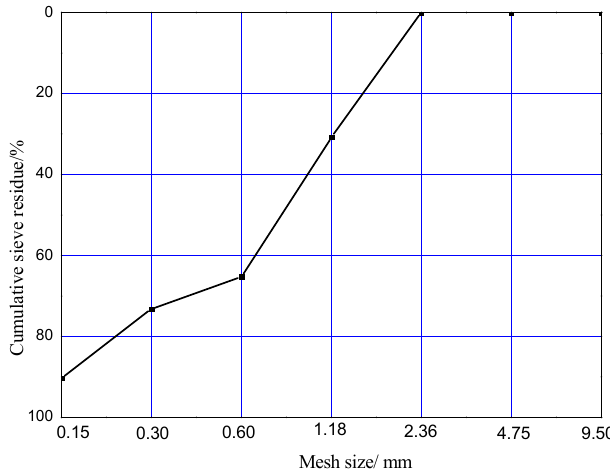
Figure 1. The gradation diagram of sand.